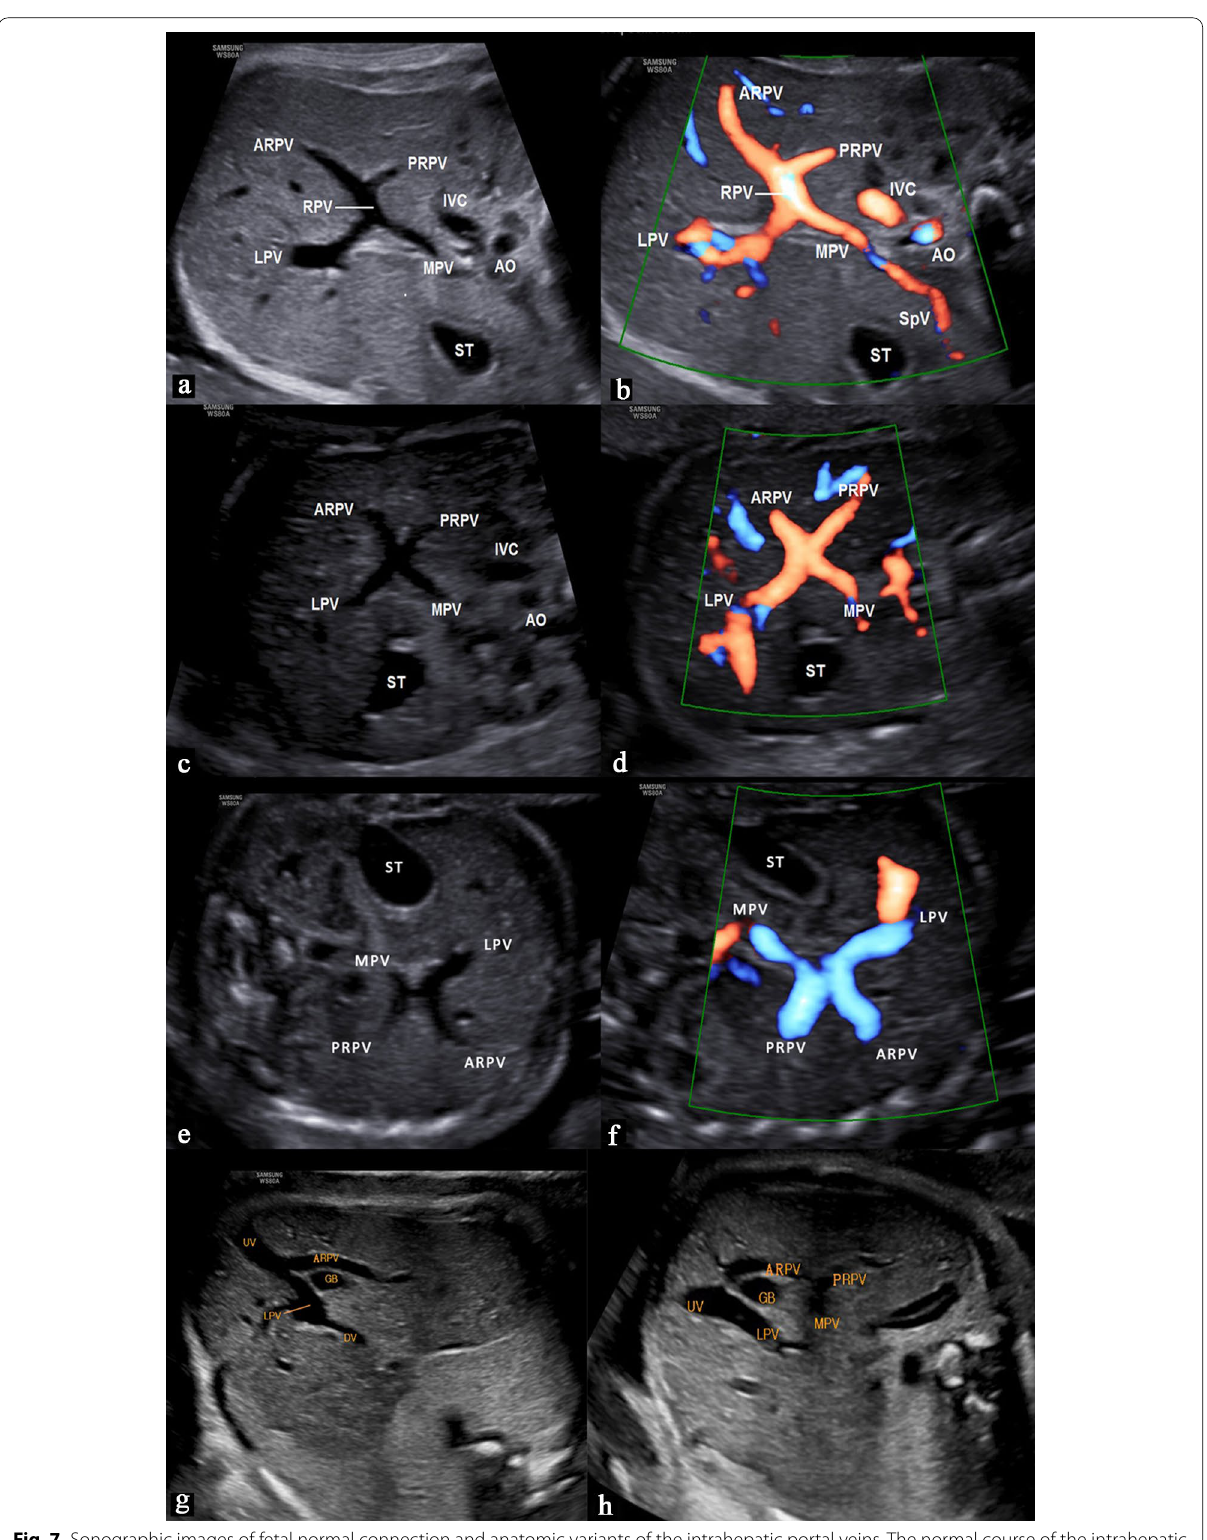
Fig. 7 Sonographic images of fetal normal connection and anatomic variants of the intrahepatic portal veins. The normal course of the intrahepatic portal veins ( a , b ). Different types of portal vein variants: Type 1, portal vein trifurcation ( c , d ); Type 2, the PRPV originates as the first branch of MPV ( e , f ); Type 3, the ARPV originates from the LPV ( g , h